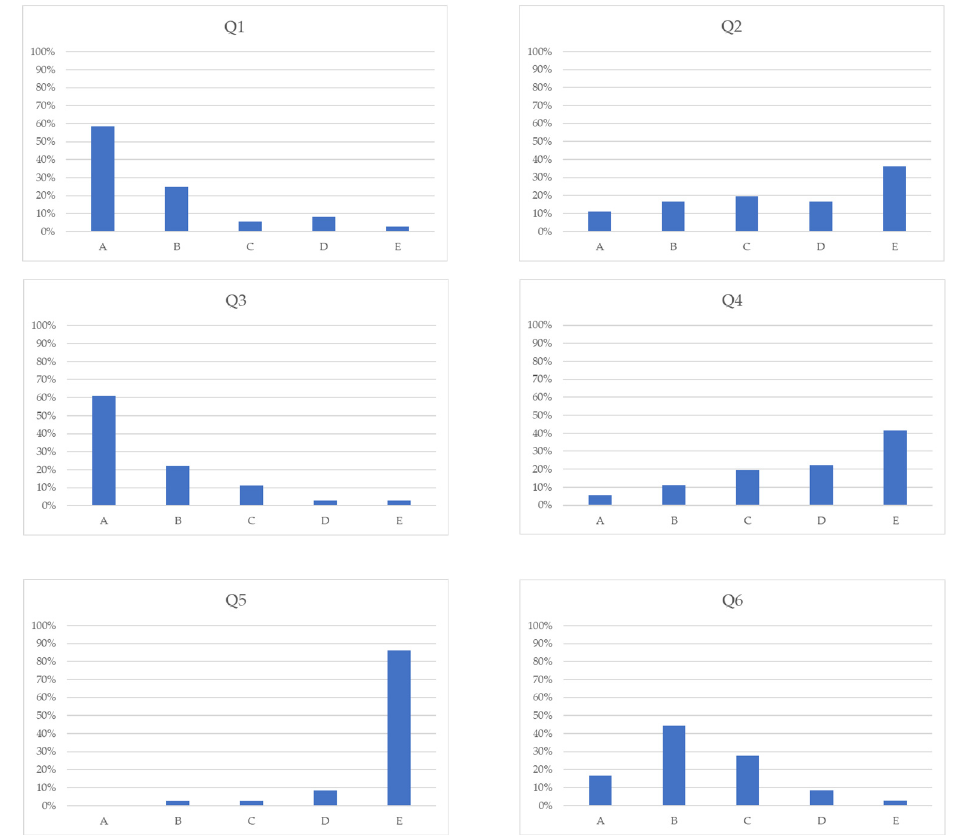
Figure 6. Distribution of responses to the questionnaire.